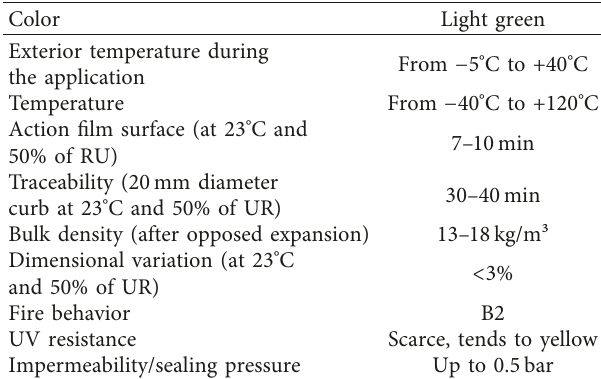
Table 7: Technical data of the